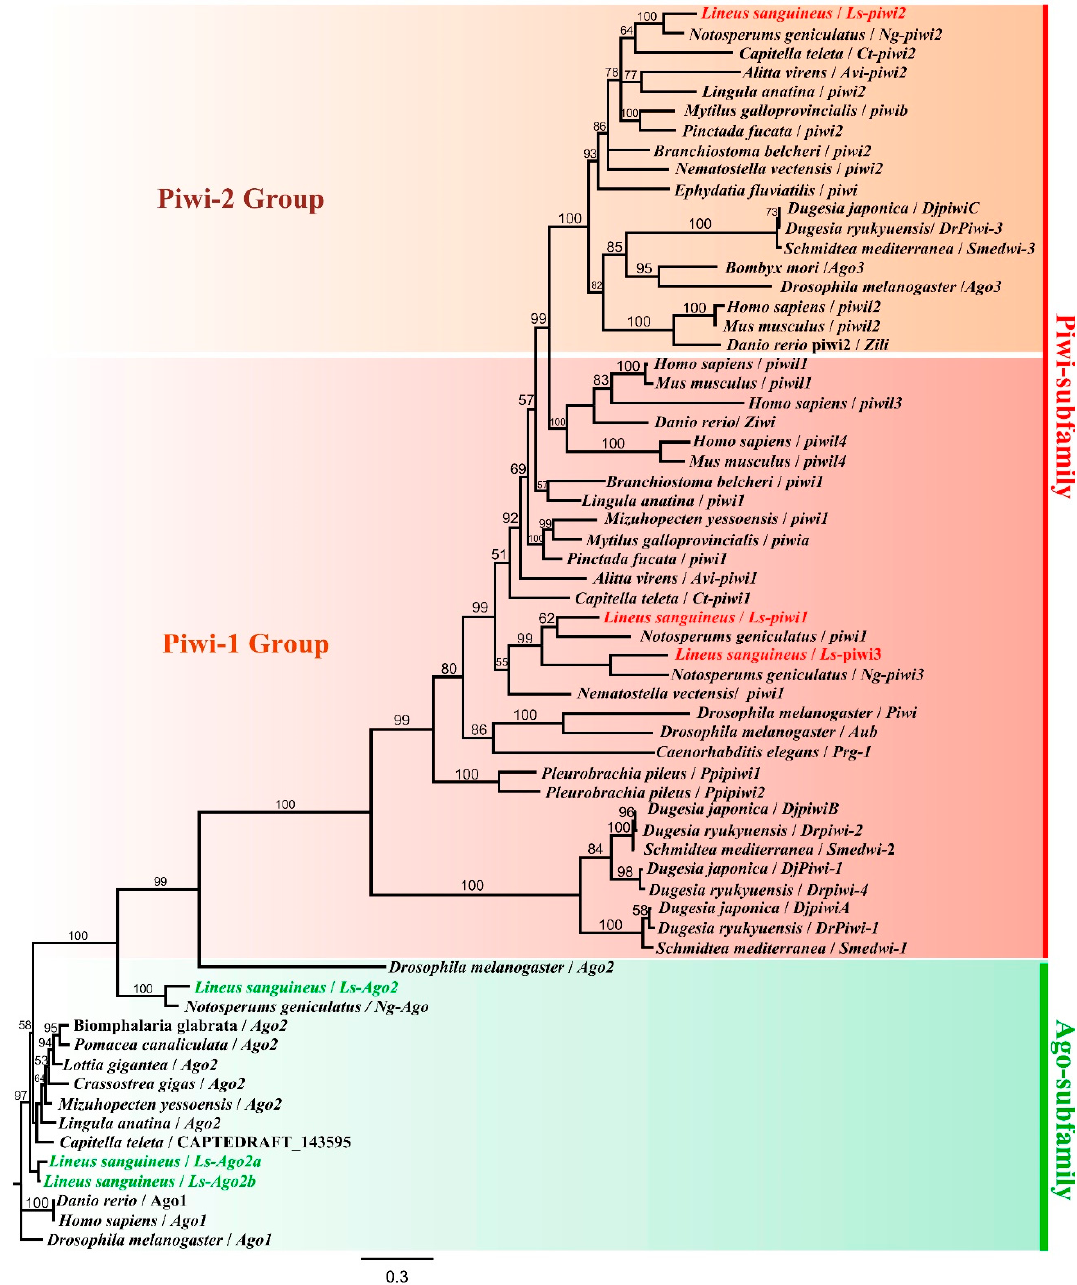
Figure 1. Bayesian consensus tree of Argonaute proteins of Lineus sanguineus and other metazoans. Posterior probabilities are shown by the numbers above the nodes.